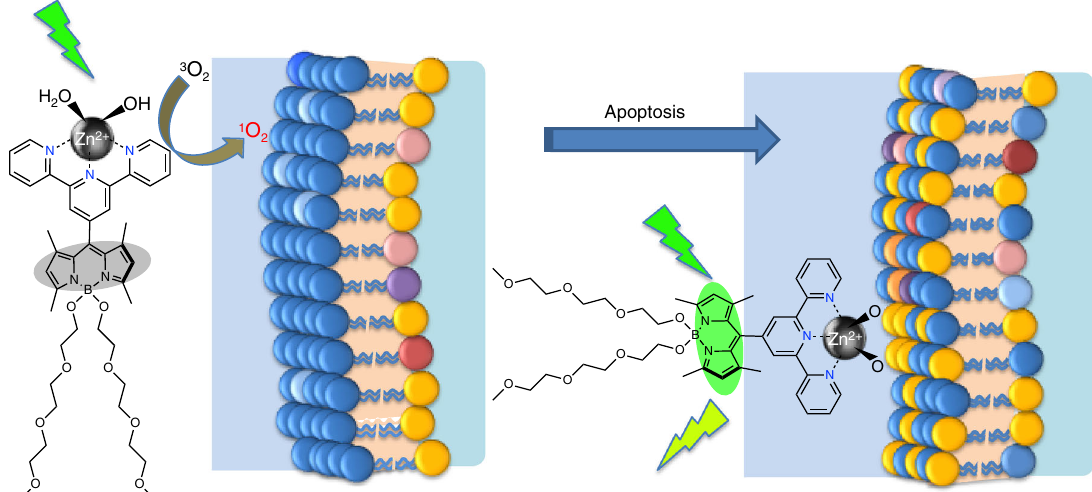
Fig. 5 T-1 induces apoptosis and then switches to diagnostic mode and fl uorescently tags apoptotic cells. Blue polar heads represent phosphatidylcholine and sphingomyelins, whereas yellow, pink and purple heads represent phosphatidylserine, phosphatidylinositol and other negatively charged lipids. Apoptosis is accompanied by a loss of membrane